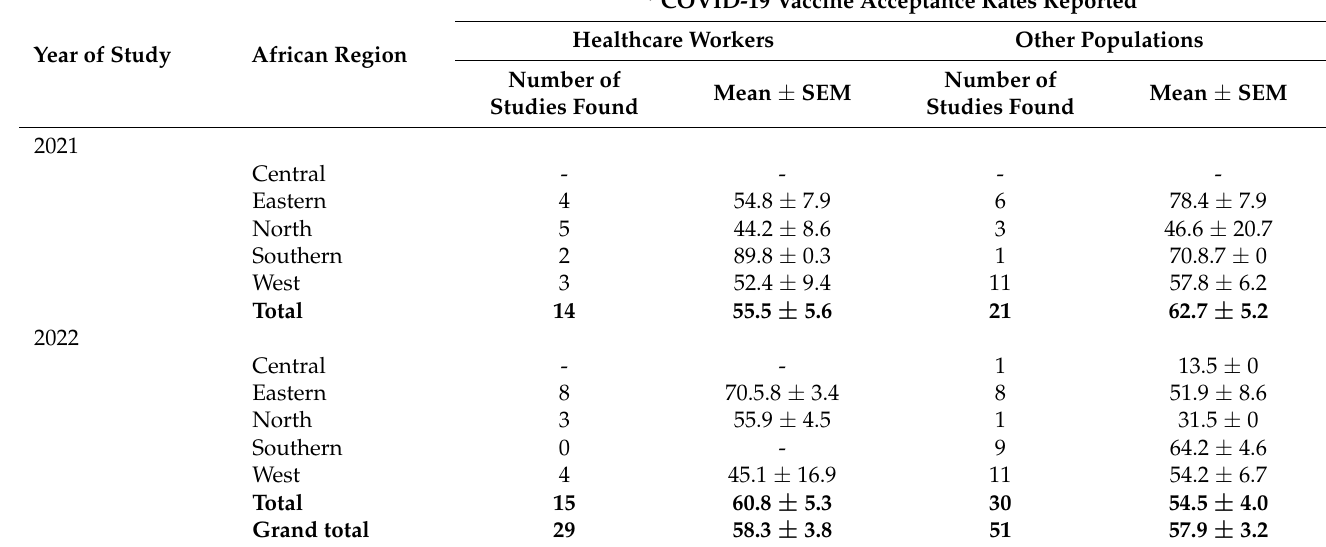
Table 3. Yearly and regional distributions of reported COVID-19 vaccine acceptance rates in Africa according to population types—healthcare workers and other populations (non-healthcare